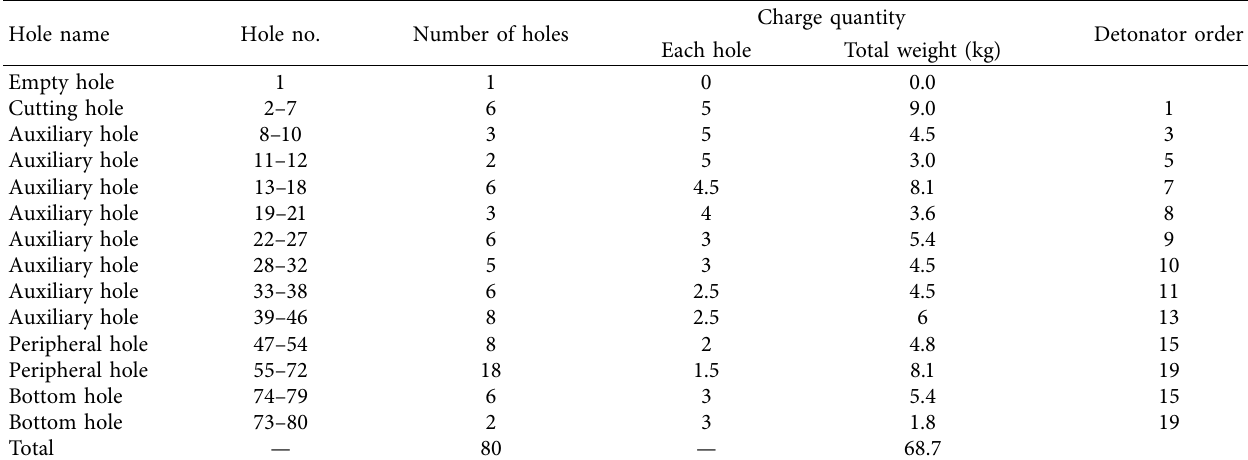
Figure 1: Layout of blasting holes (mm). Table 1: Blasting